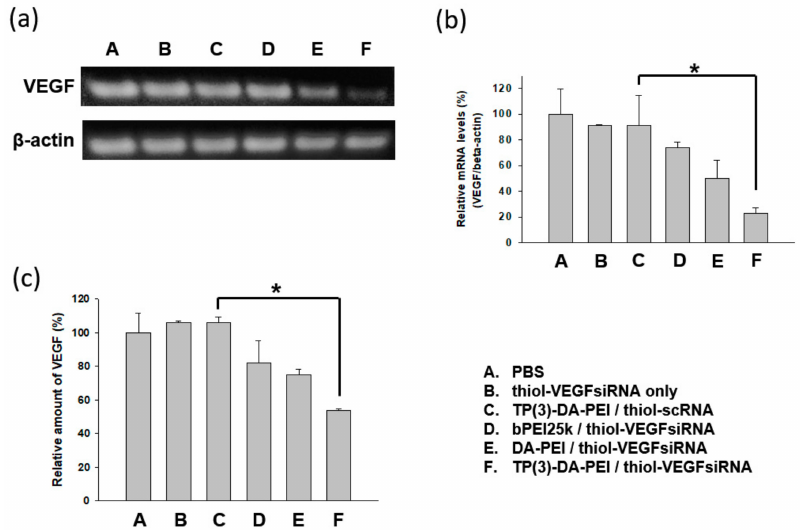
Figure 5. Vascular endothelial growth factor (VEGF) mRNA expression in A549 cells investigated by reverse transcription polymerase chain reaction (RT-PCR) showing in ( a ) the representative image ( b ) the statistical bar graph of VEGF/ β -actin relative ratios (compared with control group). ( c ) VEGF gene silencing efficiency of A: phosphate buffered saline (PBS), B: Thiol-VEGF siRNA only, C: TP(3)-DA-PEI/thiol-scramble siRNA, D: bPEI25k/thiol-VEGF siRNA, E: DA-PEI/thiol-VEGF siRNA, and F: TP(3)-DA-PEI/thiol-VEGF siRNA polyplexes in A549 cells performed by ELISA